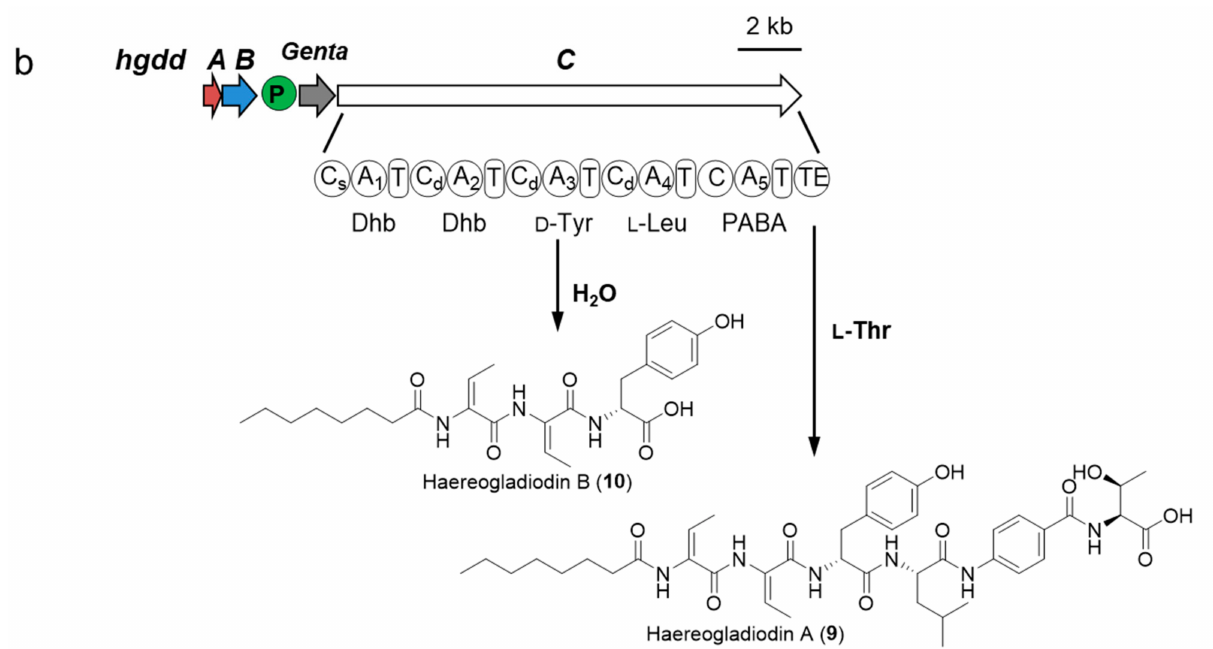
Figure 5. The proposed biosynthetic pathway of two silent biosynthetic gene clusters in B. gladioli ATCC 10248. ( a ) The NRPS module architecture of biosynthetic pathway of Chr2C2 ( bgdd ). P : promoter P genta ; Genta : gentamicin resistance gene; Bgdd A : nonribosomal peptide synthetase (NRPS) ( b ) The NRPS module architecture of biosynthetic pathway of Chr2C5 ( hgdd ). Hgdd A : Glyoxalase; Hgdd B : para-aminobenzoic acid (PABA) synthase; Hgdd C :